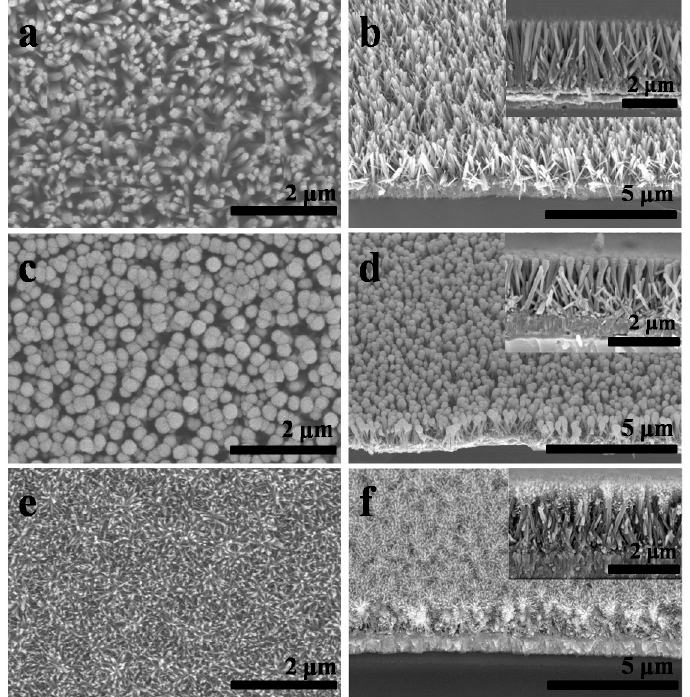
Figure 1. Surface and side-view SEM images of the TiO 2 NRAs ( a , b ); NPs/NRAs ( c , d ); and branched NRAs ( e , f ). The insets in b, d and f show high-magnification SEM images of TiO 2 NRAs, NPs/NRAs and branched NRAs, respectively. and branched NRAs,